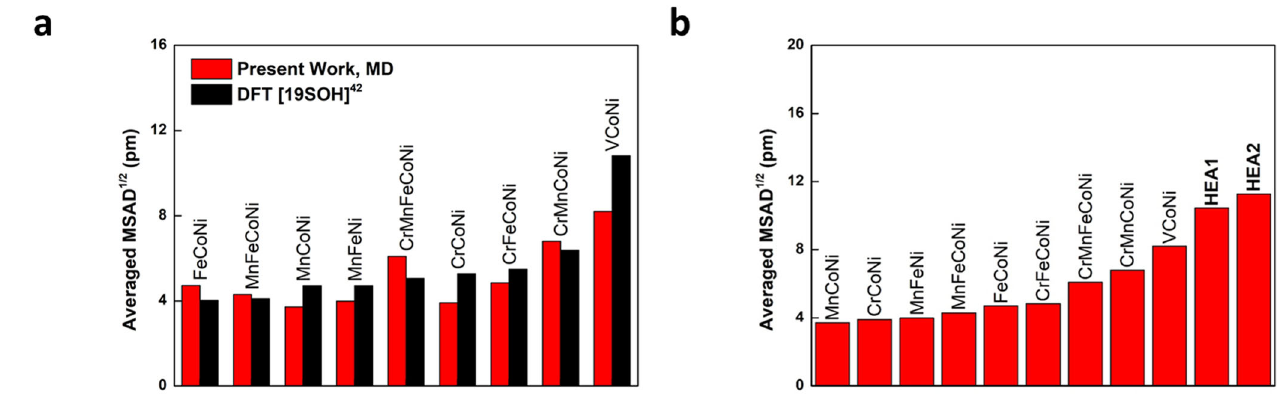
Fig. 6 Lattice distortion effect. a Comparison of MSAD calculations for MD and DFT 42 . b Calculation of MSAD for various alloys using MD simulation including the designed HEAs. Table 4. Averaged MSAD 1/2 and YS at 300 K of the designed HEAs and the HEAs compared with the designed